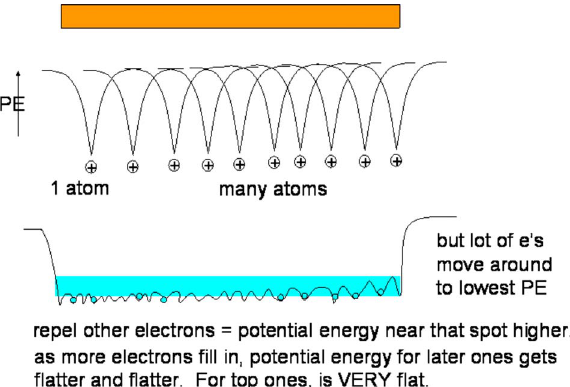
FIG. 10. (cid:1) Color (cid:2) An illustration of how to build up a square well by adding up the Coulomb wells of individual atoms (cid:1) taken from slides used in lecture in Spring 2006, Fall 2006, and Spring 2007 (cid:2) . This is a simplified sketch in which the discontinuities of the po- tential at the ion cores are smoothed over and irrelevant details such as the zero of potential are not